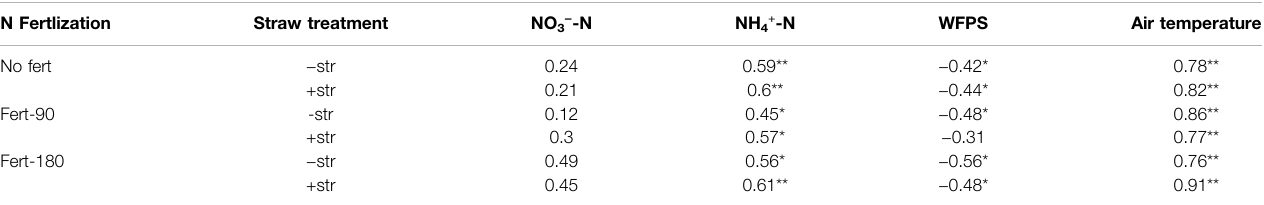
TABLE3| SpearmancorrelationRvalueforN 2 O fl uxesin2014differentiatedbyfertilizertreatment(Nofert,Fert-90,Fert-180)andstrawaddition( − str,+str).Concentrations of NO 3 − -N, NH 4 -N and WFPS refer to the uppermost soil layer (0 – 0.15 m). N Fertlization Straw